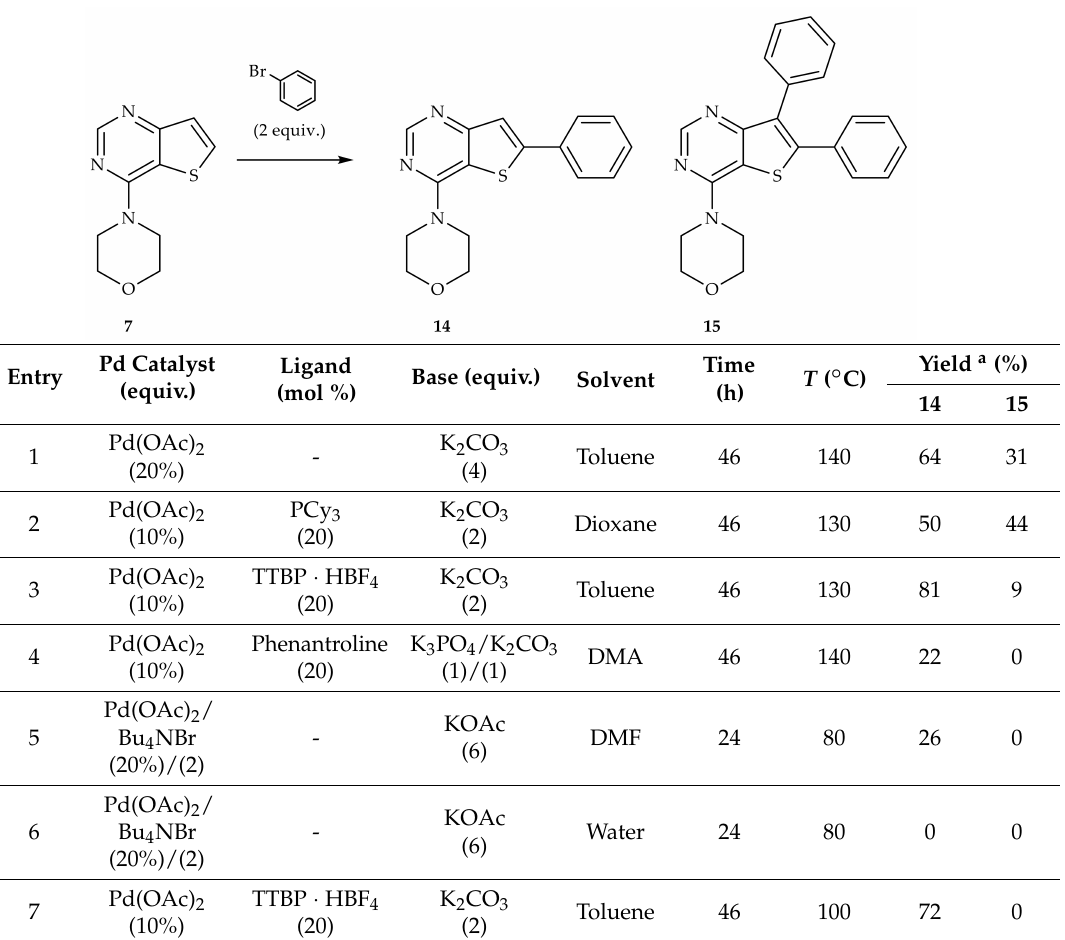
Table 3. Optimization of the C–H activation with regioselectivity in position C-2 of 4-(thieno[3,2- d